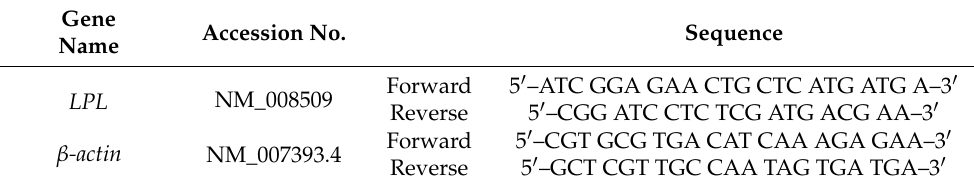
Table 1. Cont. Gene